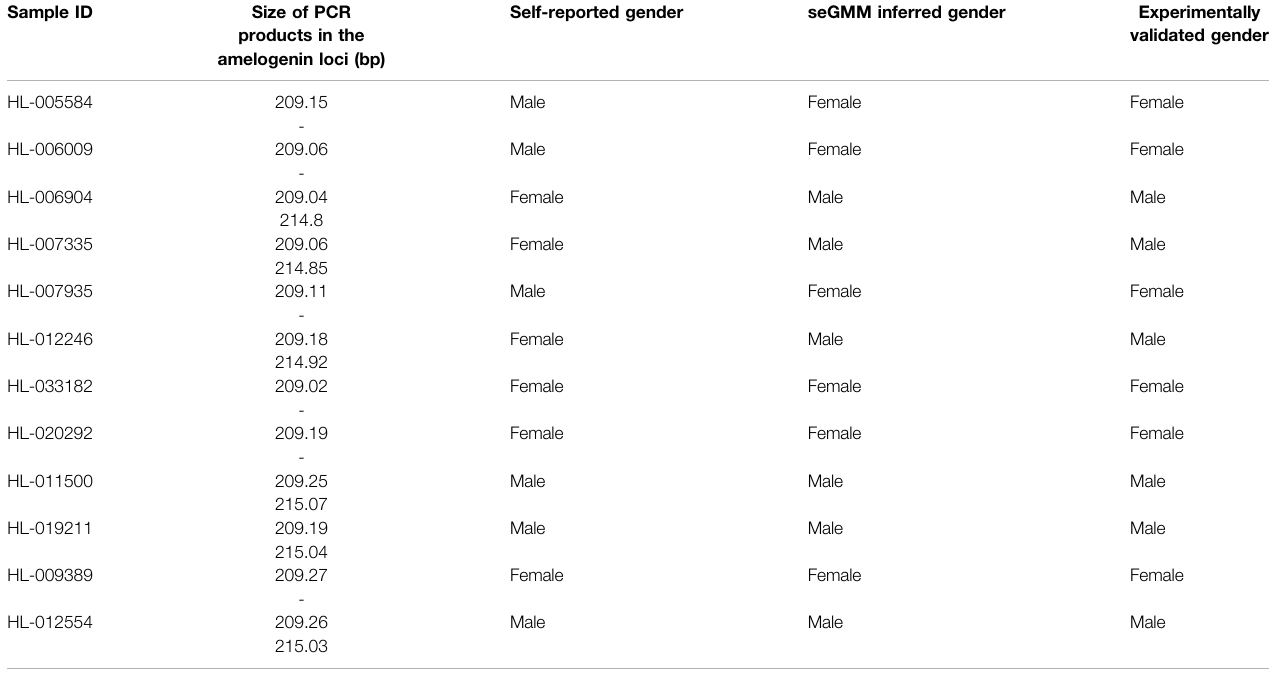
TABLE 4 | Experimental veri fi cation of gender prediction results for samples in the in-house WES data. Sample ID